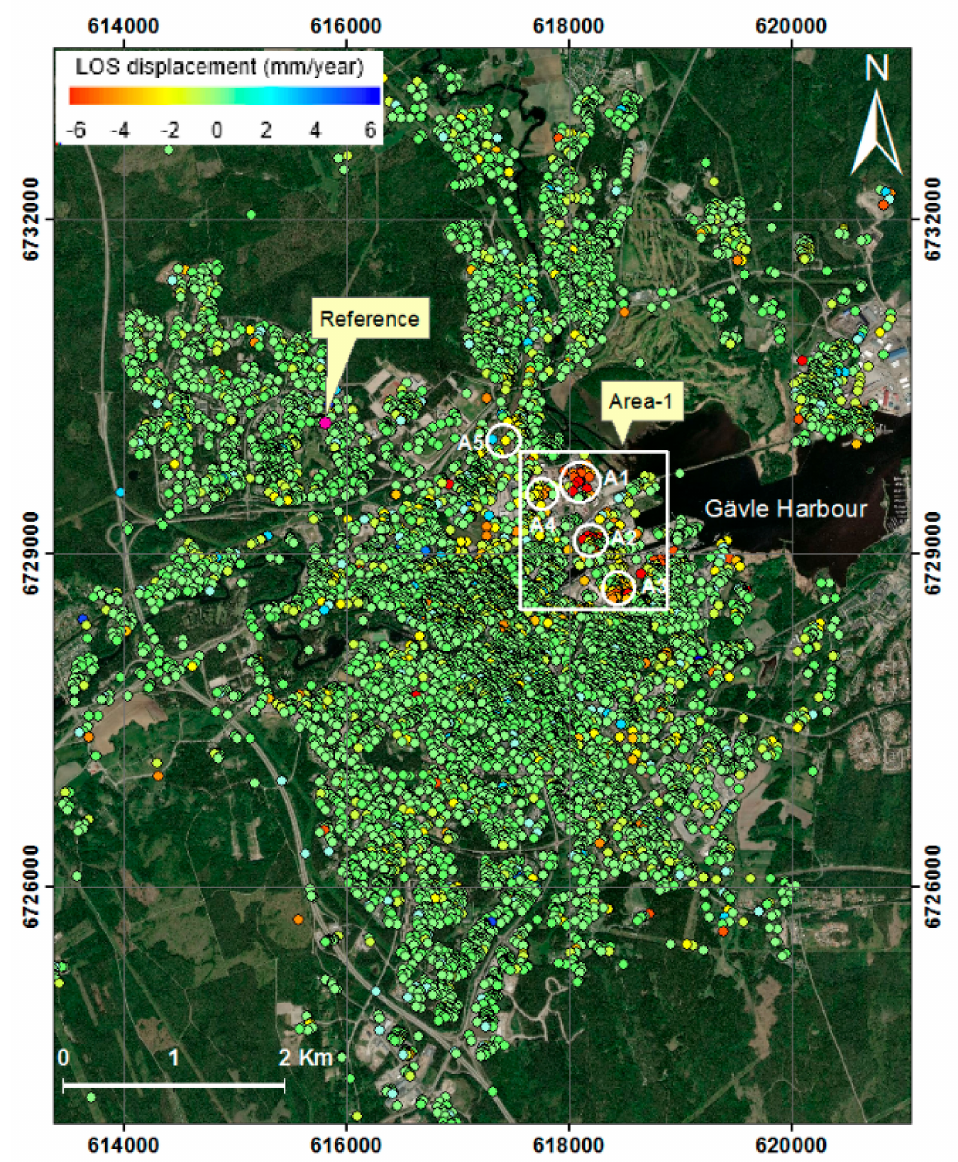
Figure 4. LOS displacement rates of all generated descending PS points in Gävle city relative to the reference point (pink color). Area-1 shows the maximum displacement zone. A1–A5 refer to the five di ff erent small areas. The observation period is from June 2015 to May 2020. Coordinate system: SWEREF